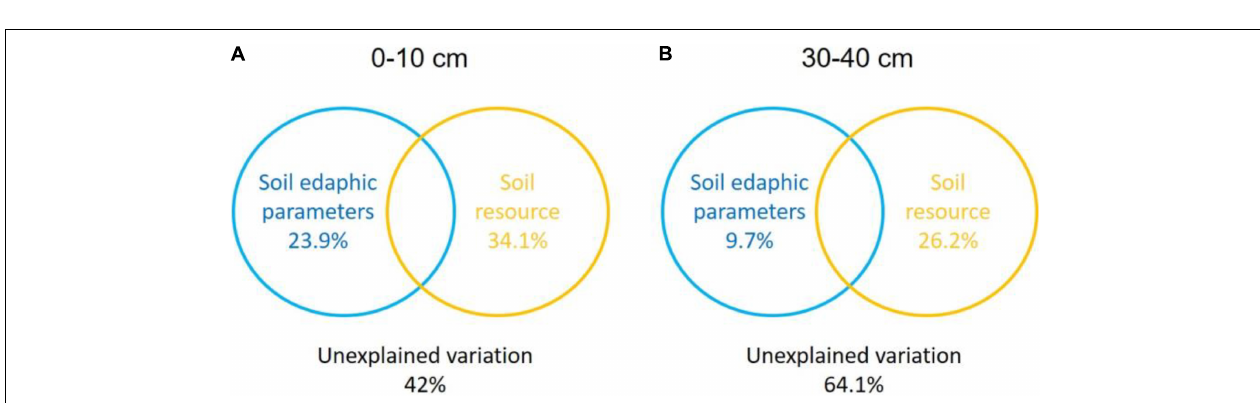
Frontiers in Plant Science |